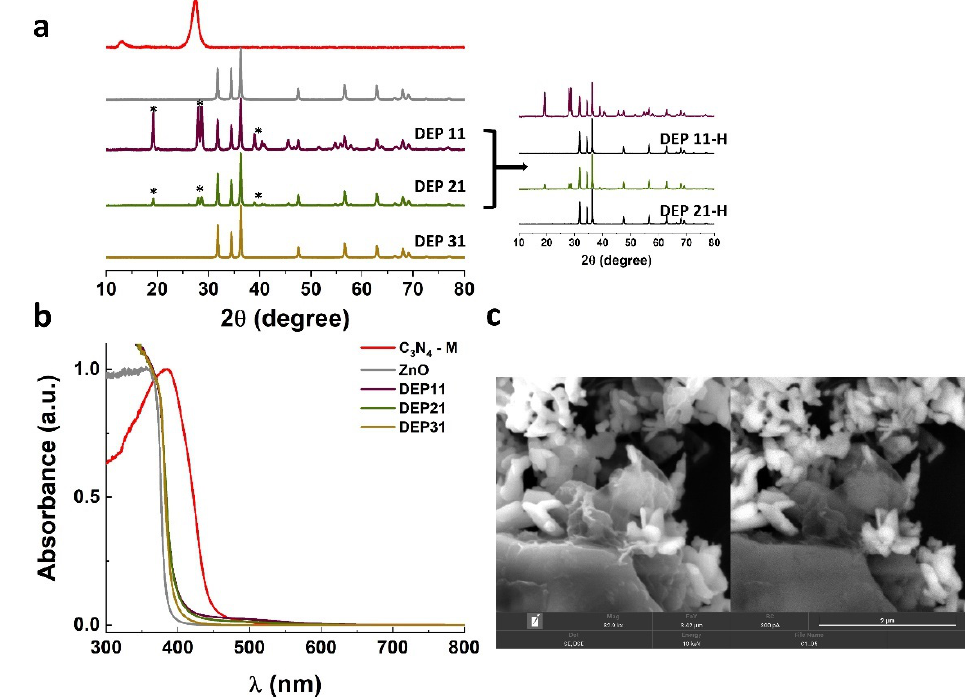
Figure 4. ( a ) XRPD pattern (in the extended part, the diffractograms of the DEP 11 and DEP 21 samples before and after (DEP 11-H and DEP 21-H) the second hydrothermal treatment are reported), ( b ) DRS-UV spectra and ( c ) FESEM images (secondary electrons on the left and backscattered electrons on the right) of DEP 31 heterojunction.